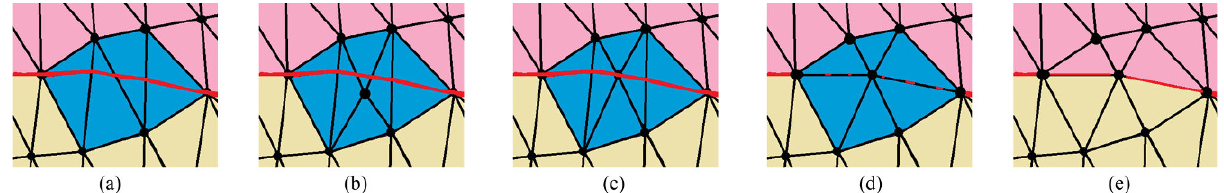
Fig. 5 Edge splitting and consecutive operations (Case II). (a) Before splitting. (b) After splitting the middle edge. (c) New vertex translated to the curve. (d) Edges flipped. (e) Face labeling.